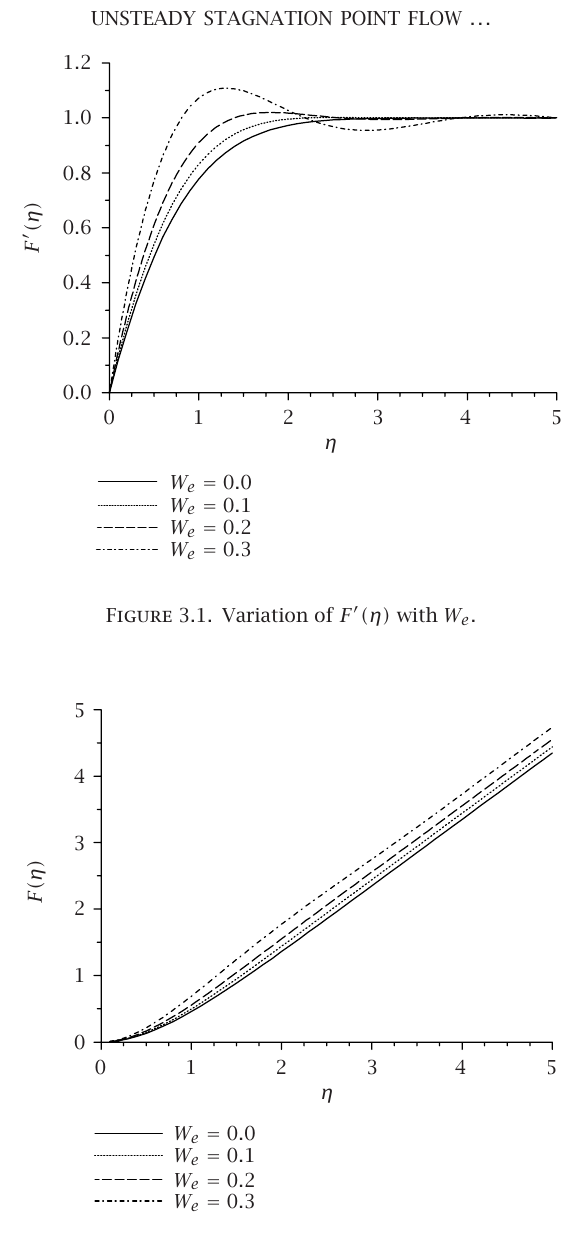
Figure 3.2 . Variation of F(η) with W e